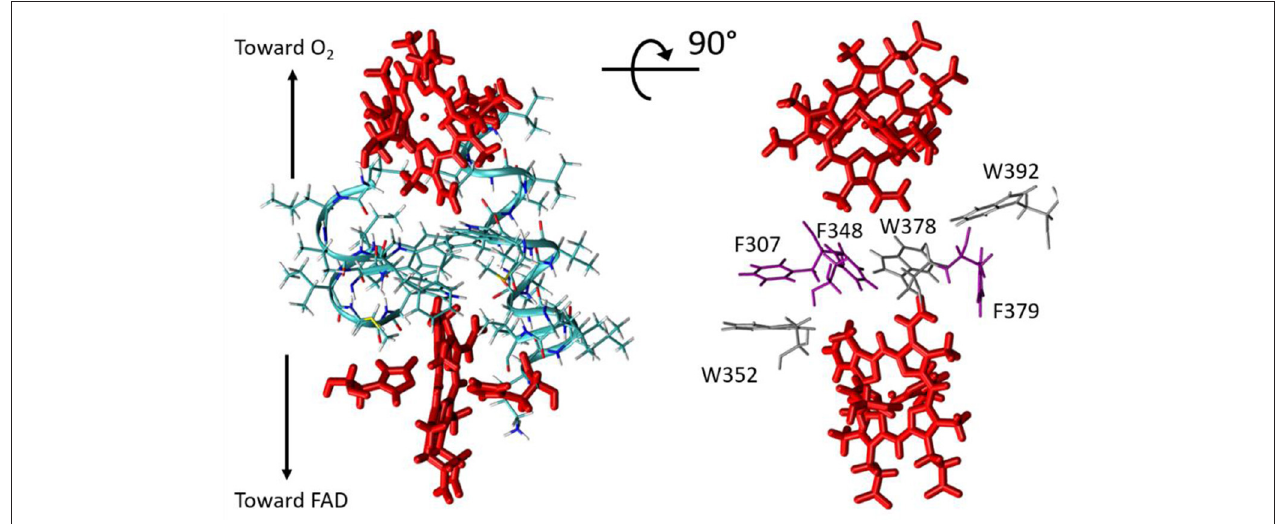
FIGURE 5 | Left, restricted molecular system considered in ET pathway analyses. The hemes are shown in red. Right, for clarity only the closest residues from the Donor-Acceptor axis are represented (tryptophan residues in gray and phenylalanine residues in violet).